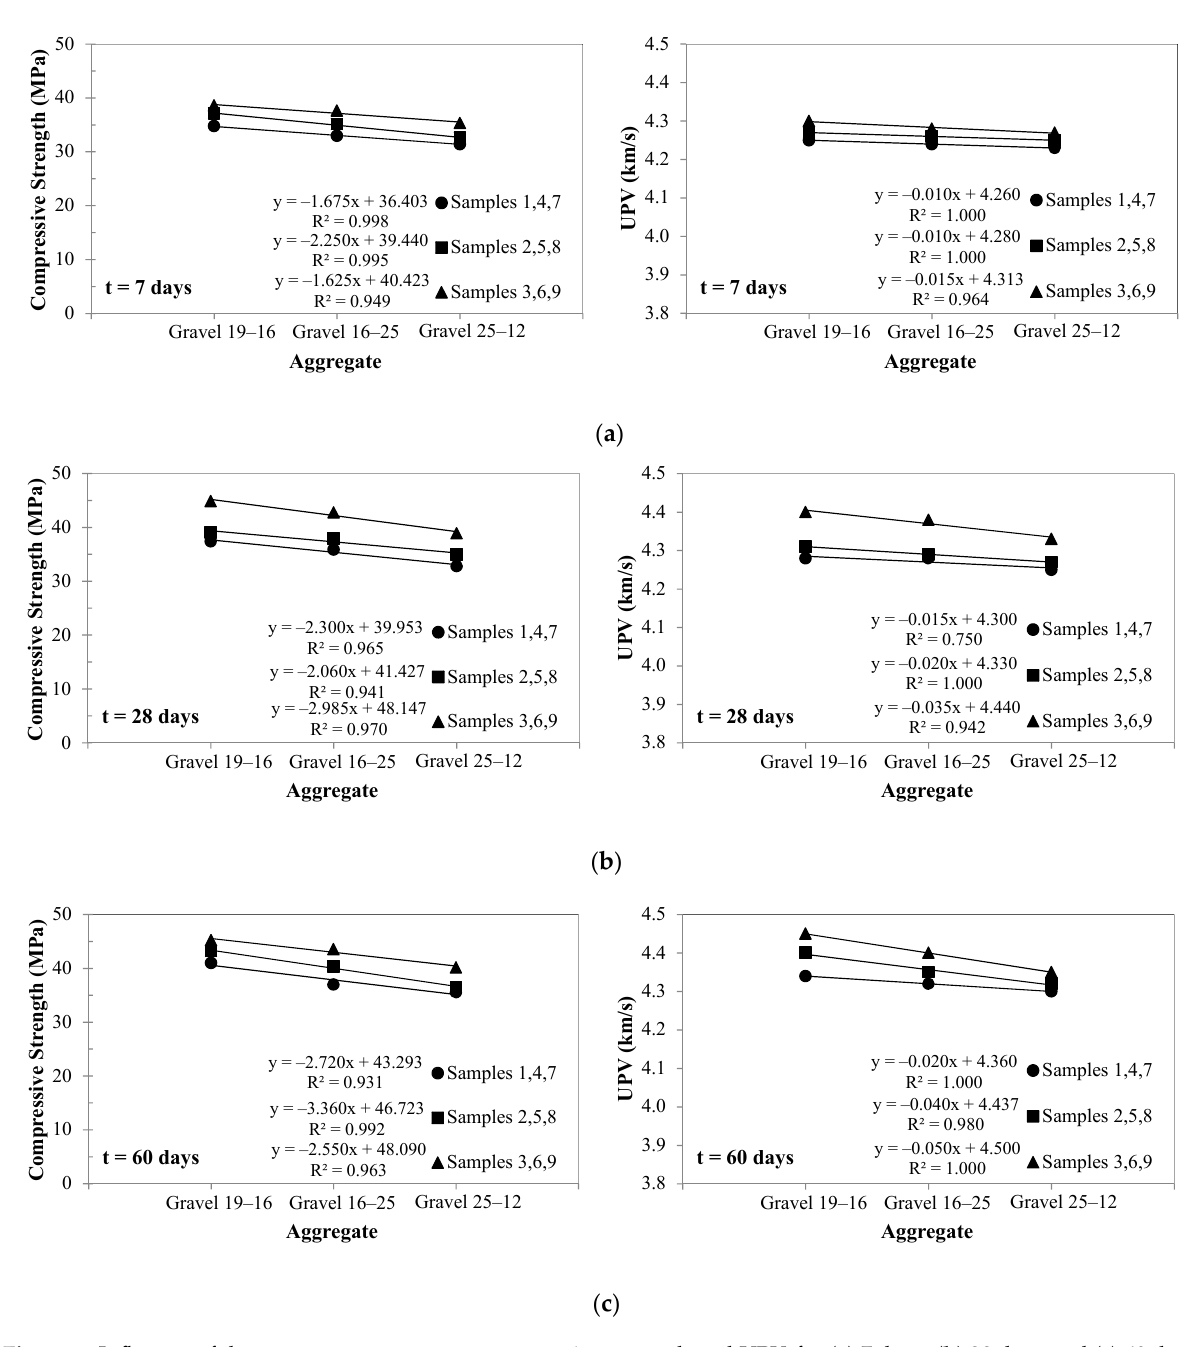
Figure 4. Influence of the aggregate on concrete compressive strength and UPV, for ( a ) 7 days, ( b ) 28 days and ( c ) 60 days.